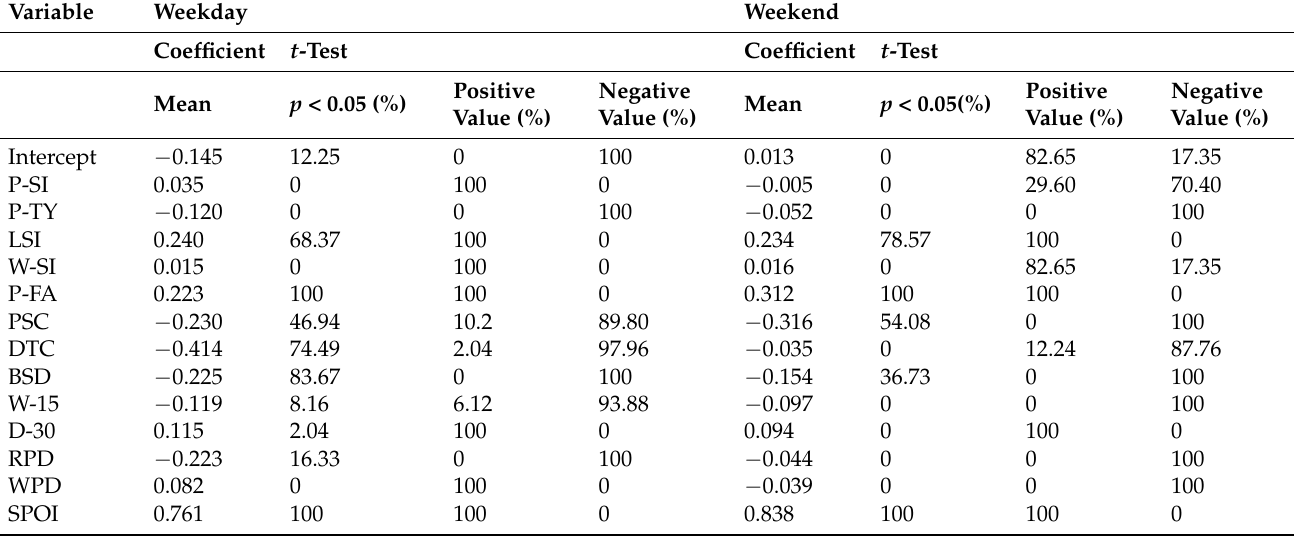
Table 4. Regression results of MGWR